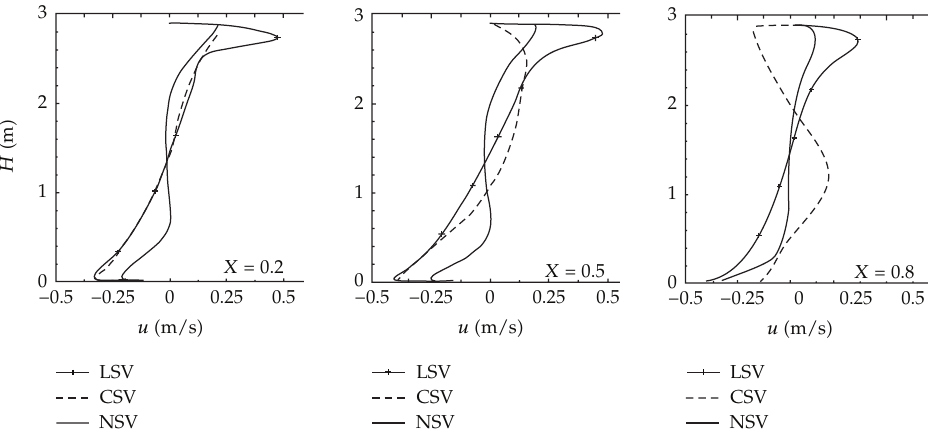
Figure 4: The velocity distributions at di ff erent X locations for the cases shown in Figure